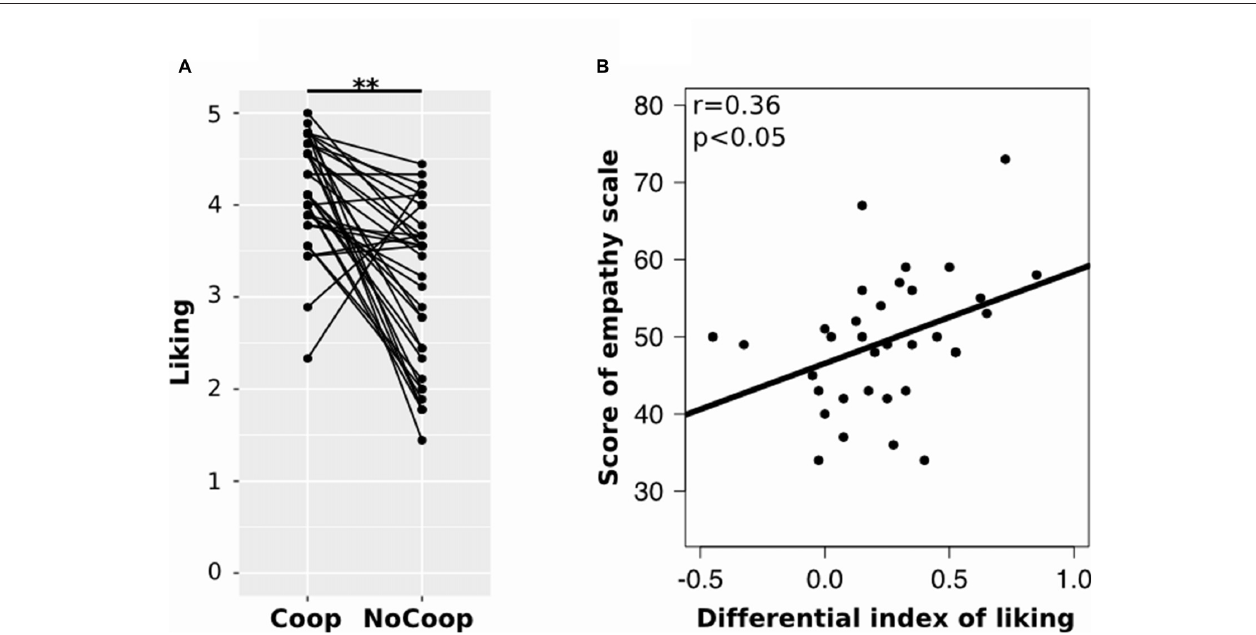
FIGURE 4 | Results of the post-scan scales. (A) Post-scan ratings of participants in scale of liking for each confederate: cooperative (Coop) and non-cooperative (NoCoop). Bars represent the mean and the error bars show the standard error. (B) Correlation of scores of empathy scale, EQ, with differential index of linking scale. ∗∗ p <